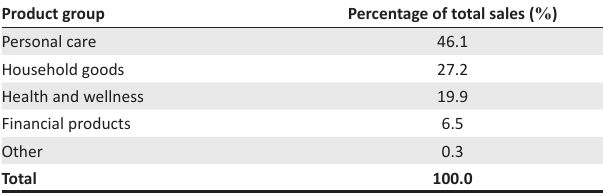
TABLE 2: Product mix of South Africa’s Direct Selling Association.